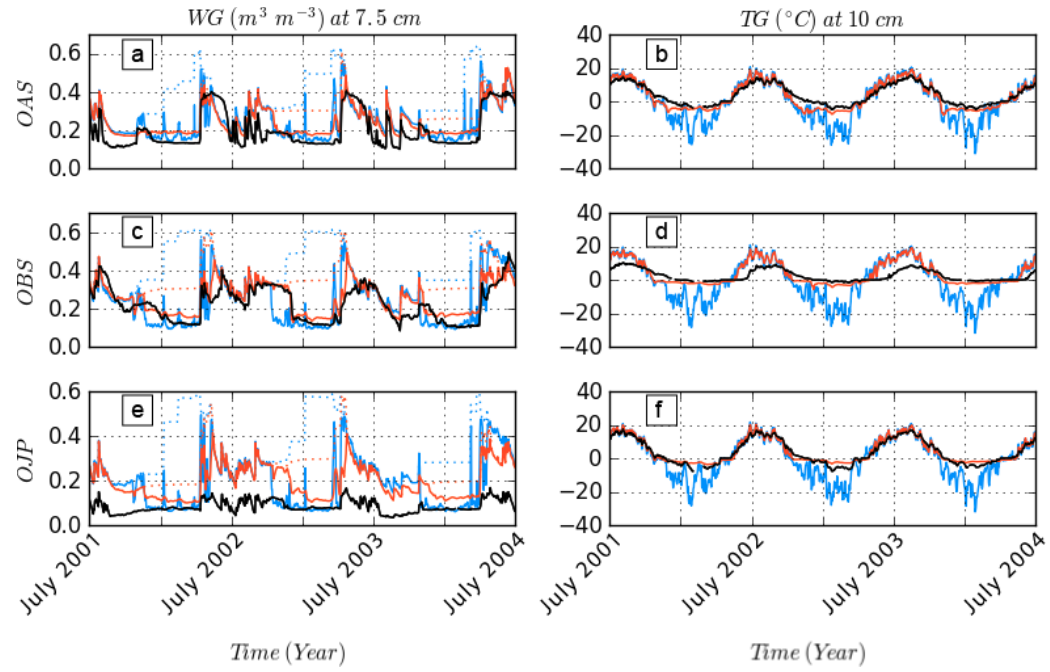
Figure 9. Soil water content and temperature at 7.5 and 10cm depth, respectively, for the three sites from 2 July 2001 to 2 July 2004. MEB is in red, ISBA is in blue, and observations are in black. On the WG (soil water) graphs, the dotted lines represent the liquid and solid